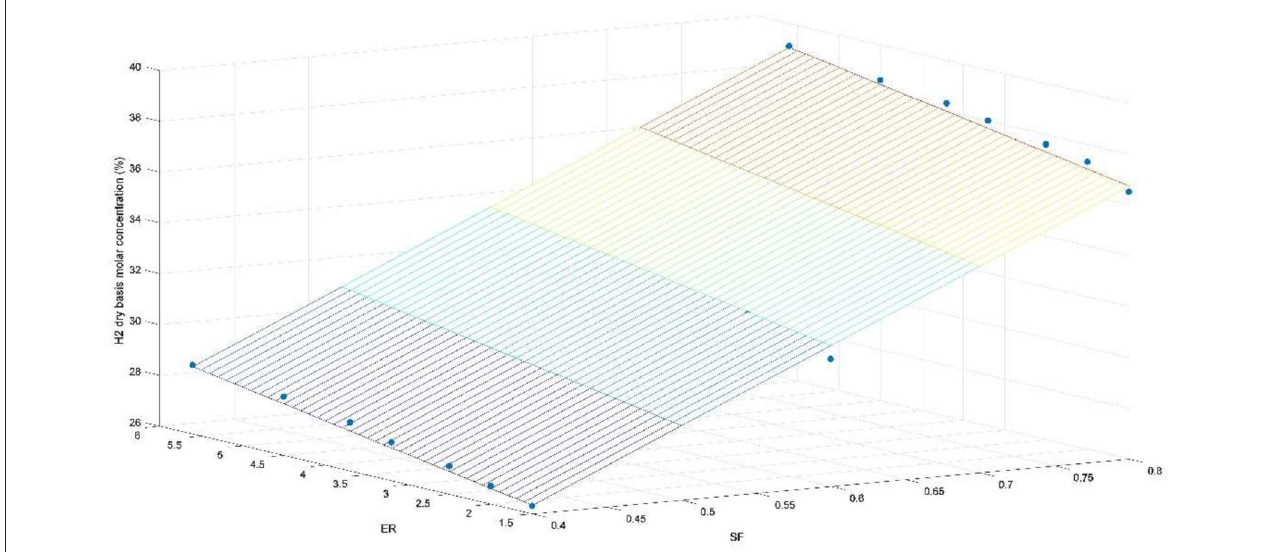
FIGURE 9 | Fitted plane as a function of ER and SF for dry H 2 concentration.